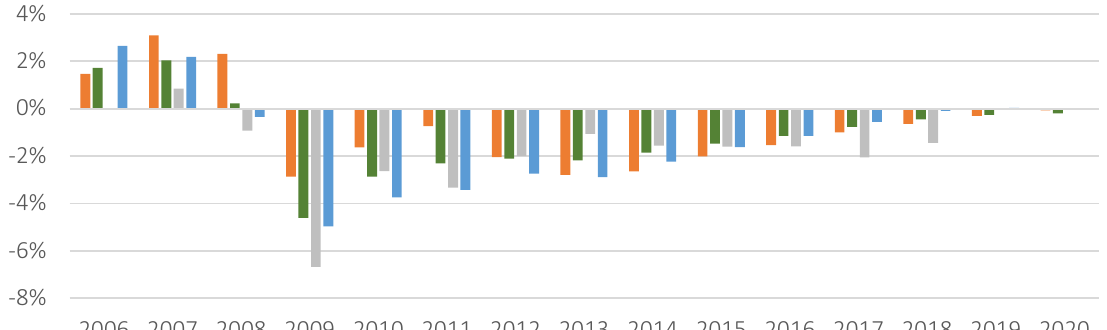
Figure 6. The impulse response of the model ARMA (1,2) Source: Built by the authors on the results of the simulation.